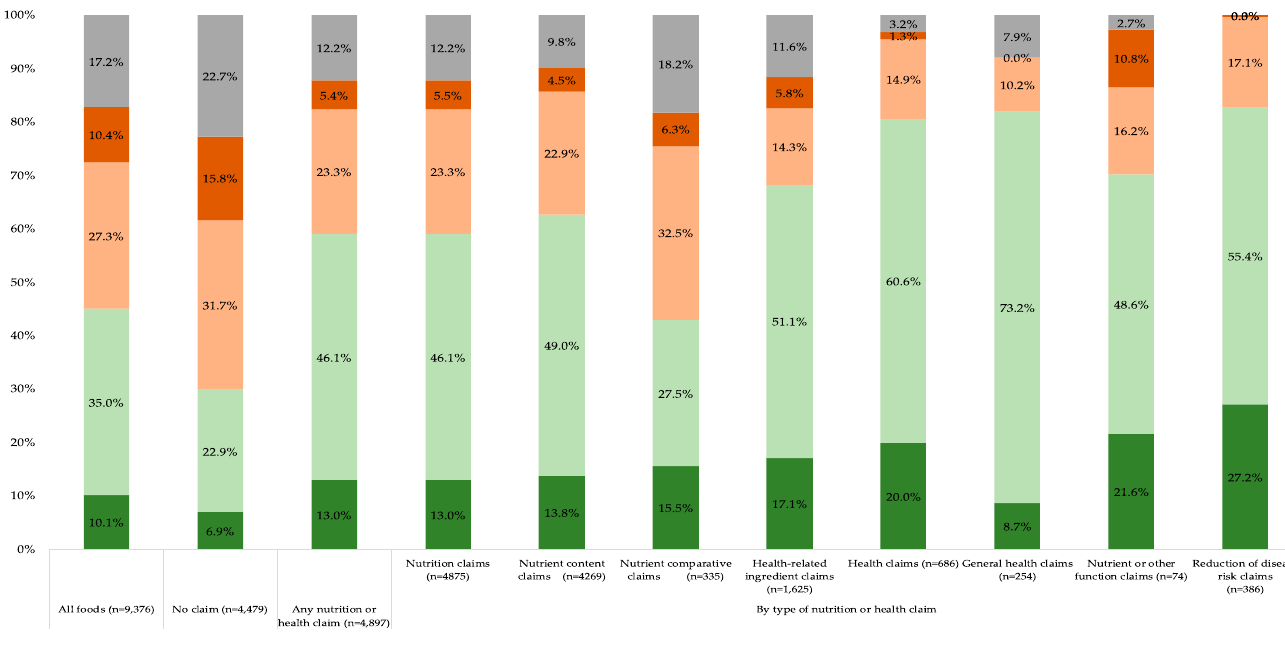
Figure 1. Proportion of foods and beverages in each tier by type of nutrition marketing.